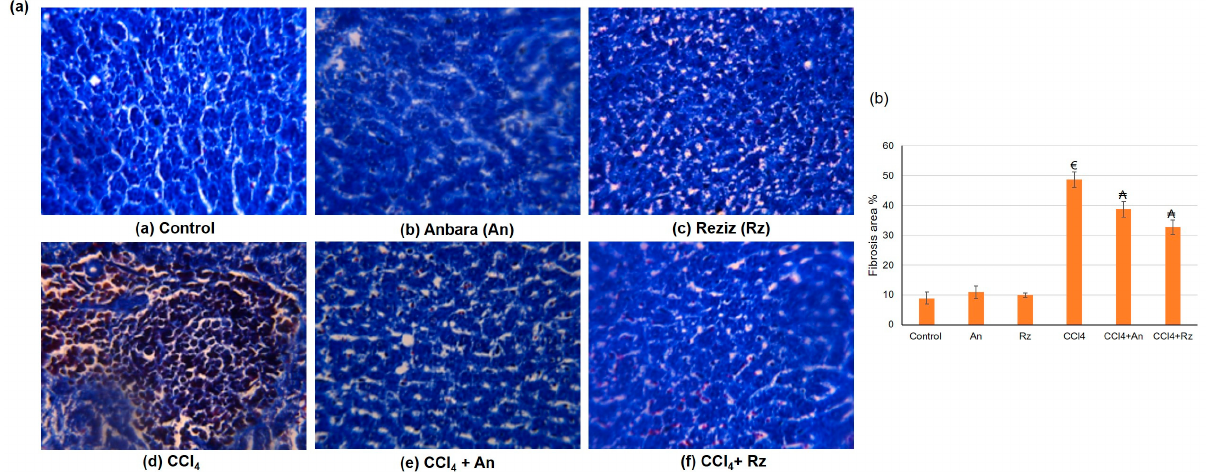
Figure 6. ( a ) Histological examination using Masson’s trichrome (MT) exposing that control, An, and Rz possess normal liver tissues showing no collagen precipitation, the CCl 4 group present collagen fibers’ augmentation, CCl 4 + An and CCl 4 + Rz display reduced accumulation of collagen fibers and less fibrosis, and almost no steatosis was observed (×400) ( b ) Fibrosis area percentage. € describes a statistically significant correlation with the control, ( ₳ ) denotes a statistically significant correlation with the CCl 4 -induced hepatotoxicity group.